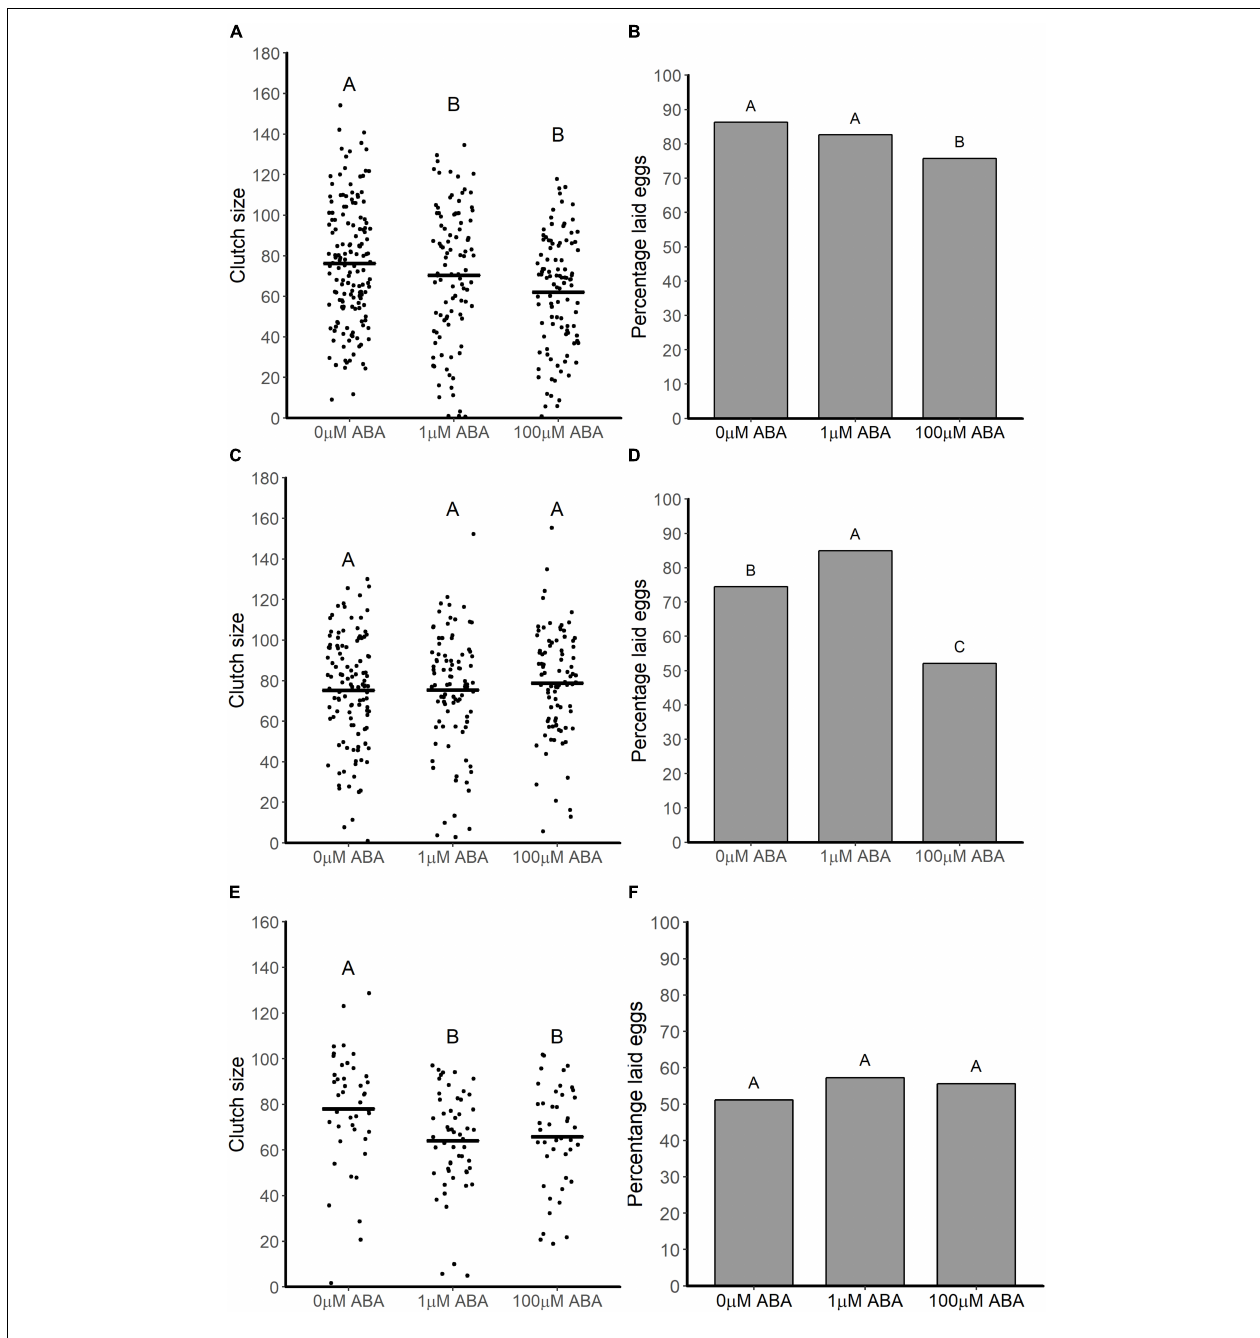
FIGURE 5 | ABA treatment of larval A. stephensi variably reduced clutch sizes and percentages of ovipositing adult females across the first (A,B) , second (C,D) and third (E,F) gonotrophic cycles. (A) Female mosquitoes derived from larvae treated with 1 and 100 µ M ABA had reduced clutch sizes in the first gonotrophic cycle compared to controls (Tukey p < 0.001 and p < 0.001, respectively). Each dot represents the clutch size of a single female mosquito from four biological replicates; black bars represent means. (B) Treatment of larvae with 100 µ M ABA reduced the percentage of ovipositing females relative to controls in the first gonotrophic cycle (Gtest p = 0.013). Data are shown as the means from three biological replicates, n = 389. (C) Larval treatment with ABA had no effect on clutch sizes of adult female A. stephensi (ANOVA F = 0.009, p = 0.99) in the second gonotrophic cycle. Each data point represents the clutch size of a single female mosquito from four biological replicates; black bars represents means. (D) Treatment of larvae with 1 µ M ABA increased the percentage of ovipositing females mosquitoes compared to controls in the (GTest p = 0.038), while treatment of larvae with 100 µ M ABA reduced the percentage of ovipositing females compared to controls (GTest p < 0.001). Data are shown as the means of three biological replicates, n = 298. (E) Larval treatment with ABA reduced clutch size in the third gonotrophic cycle (ANOVA p = 0.012; Tukey p = 0.017 for 1 µ M ABA, Tukey p = 0.034 for 100 µ M ABA). Each dot represents the clutch size of a single female mosquito from four biological replicates, black bars represent the mean of each treatment. (F) Percentage of fully engorged A. stephensi that laid eggs was not affected by larval treatment with ABA (GTest p = 0.62). Data are shown as the means of three biological replicates, n = 141.